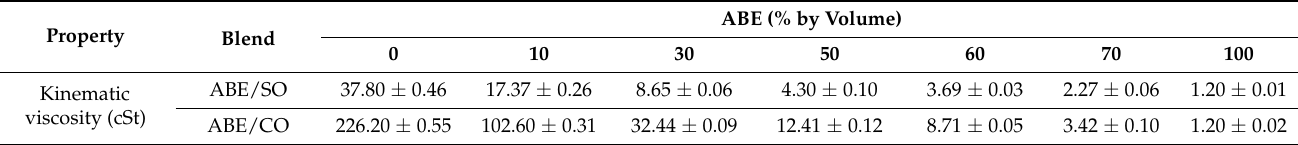
Table 4. Viscosity values at 40 ◦ C (cSt, centistokes) for ABE/sunflower oil (SO) and ABE/castor oil (CO) double blends, obtained from the addition of increasing volumes of the ABE mixture to sunflower oil or castor oil. Errors expressed as standard deviation have been calculated from the average of three measurements.